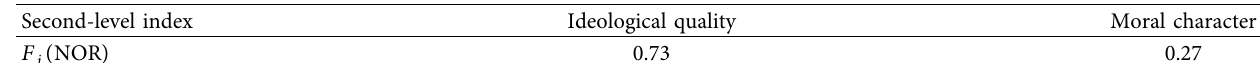
Table 15: F j (NOR) of physical and